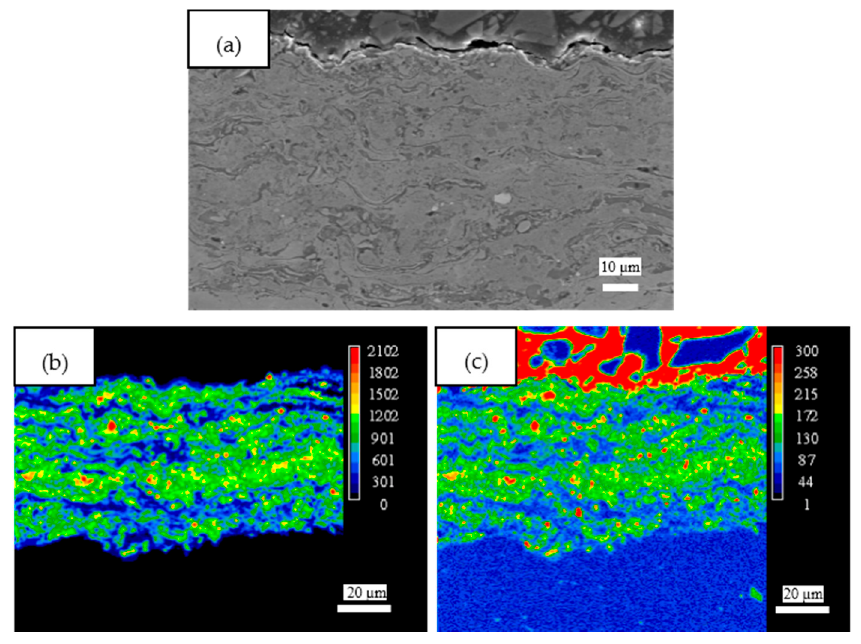
Figure 5. ( a ) SEM back-scattered image and ( b,c ) mapping of titanium and carbon respectively. Metals 2017 , 7 , 177